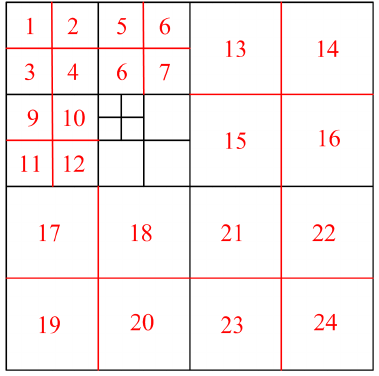
Figure 4. The mesh satisfying 2:1 condition.